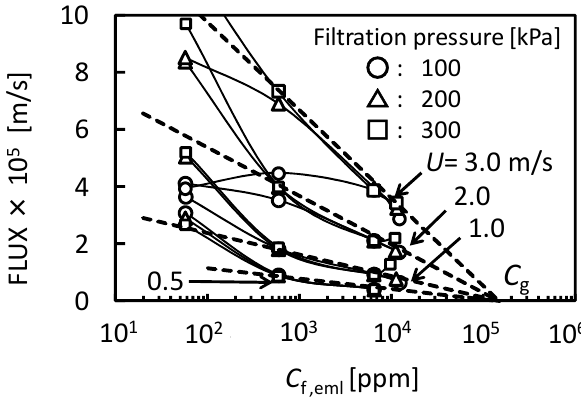
Figure 3. The relationship between the flux observed in UF (pore size 5 nm) membrane and O/W emulsion concentration as TOC. The dashed lines show linear regressions based on the gel-polarization